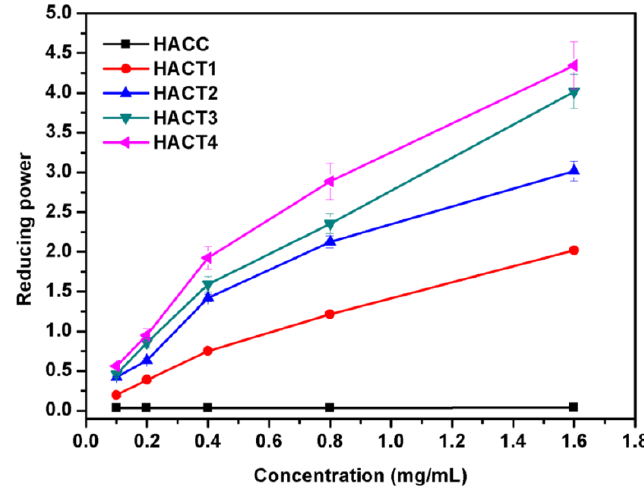
Figure 5. Reducing power of chitosan derivatives.